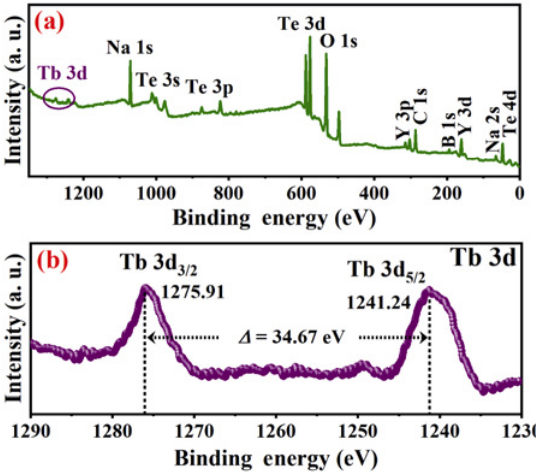
Fig. 3 (a) XPS survey scan spectrum. (b) Core-level spectrum of Tb 3d for NYTB:70%Tb 3+